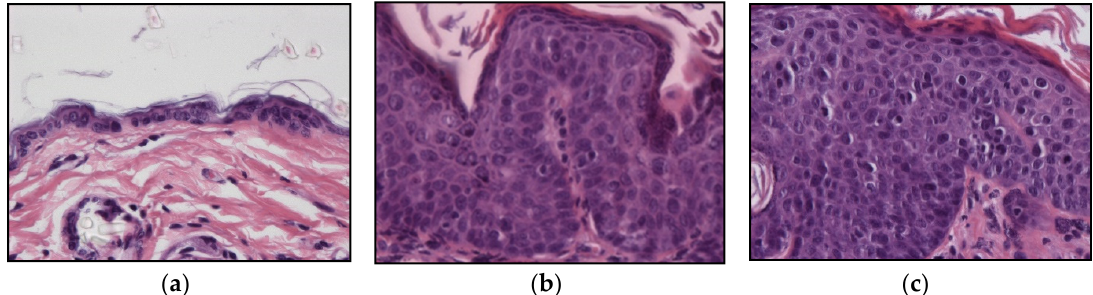
Figure3. Histologicallesionsofskin, hematoxylin, andeosinstain. ( a )Normalskin, 400 × . ( b )Epidermal Figure 3. Histological lesions of skin, hematoxylin, and eosin stain. ( a ) Normal skin, 400×. ( b ) hyperplasia, 400 × . ( c ) Epidermal dysplasia, 400 × Table 2. Incidence of skin lesions in each experimental group .